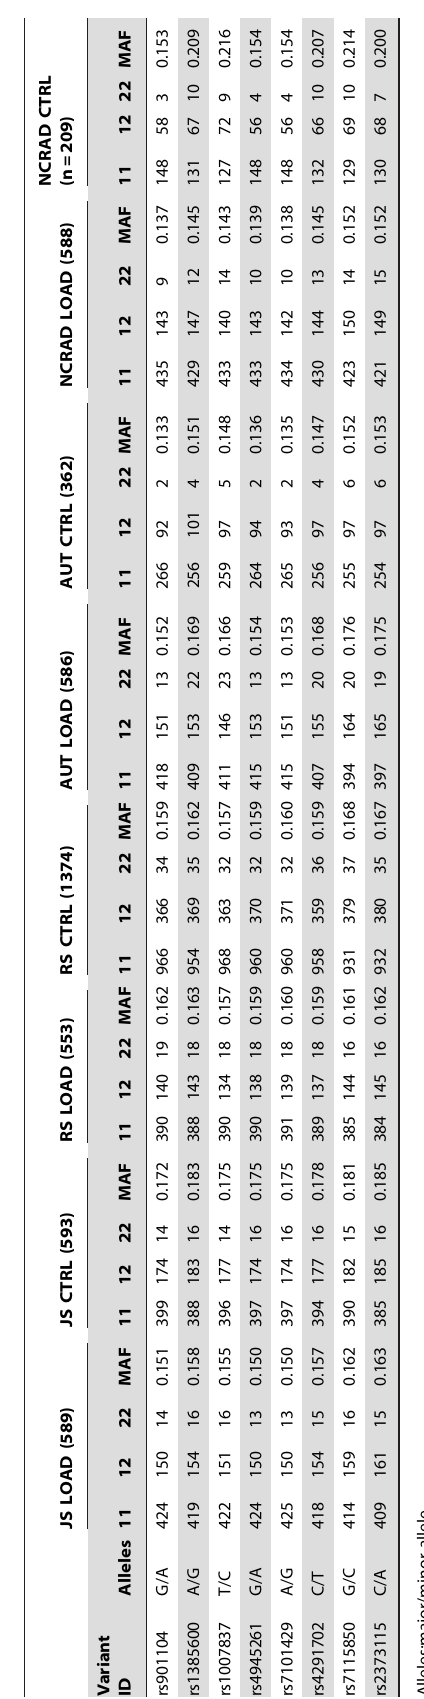
Figure 1, meta-analyses of our four case-control series (JS, RS, AUT, NCRAD) revealed no association overall for any of the eight variants with LOAD risk (all Meta p . 0.3) albeit that five variants were associated with LOAD in the NCRAD series;